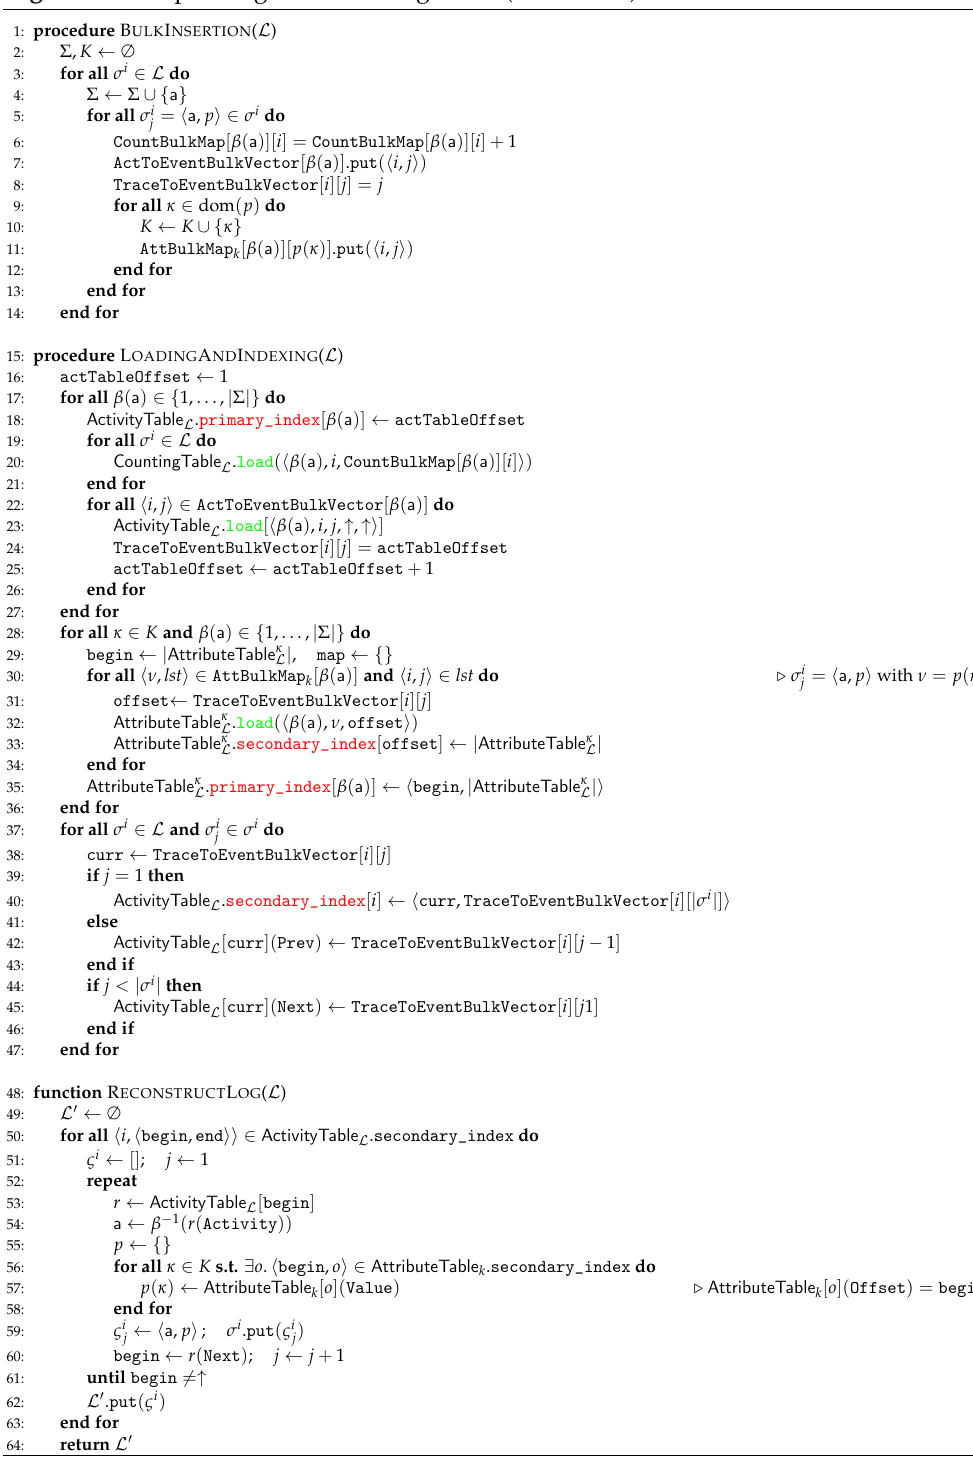
Algorithm 2 Populating the Knowledge Base (Section